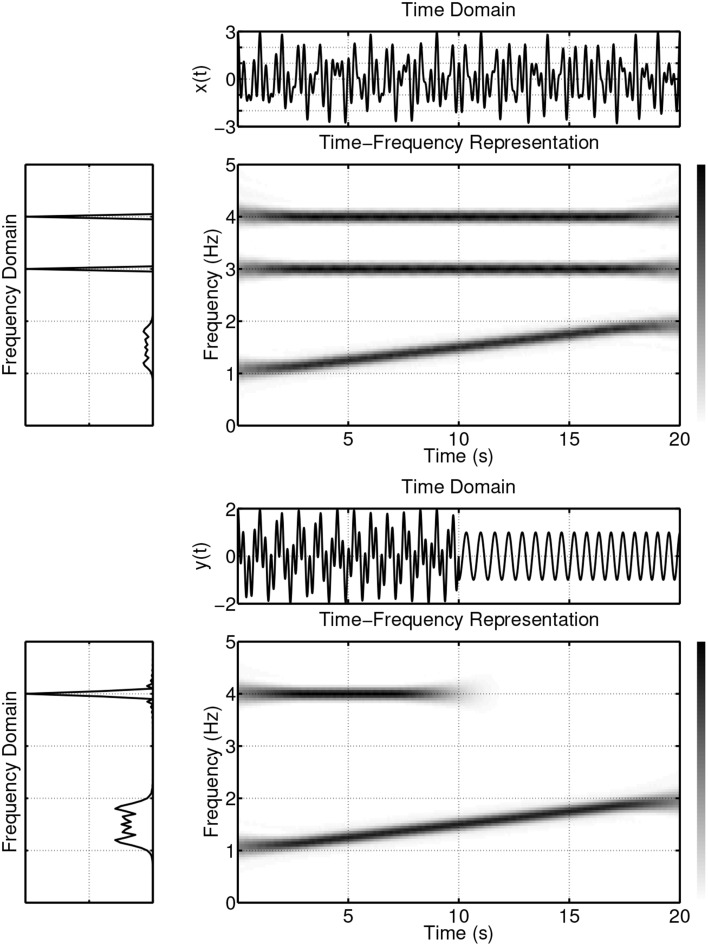
Example of two non-stationary signals in time, frequency and time-frequency domains.